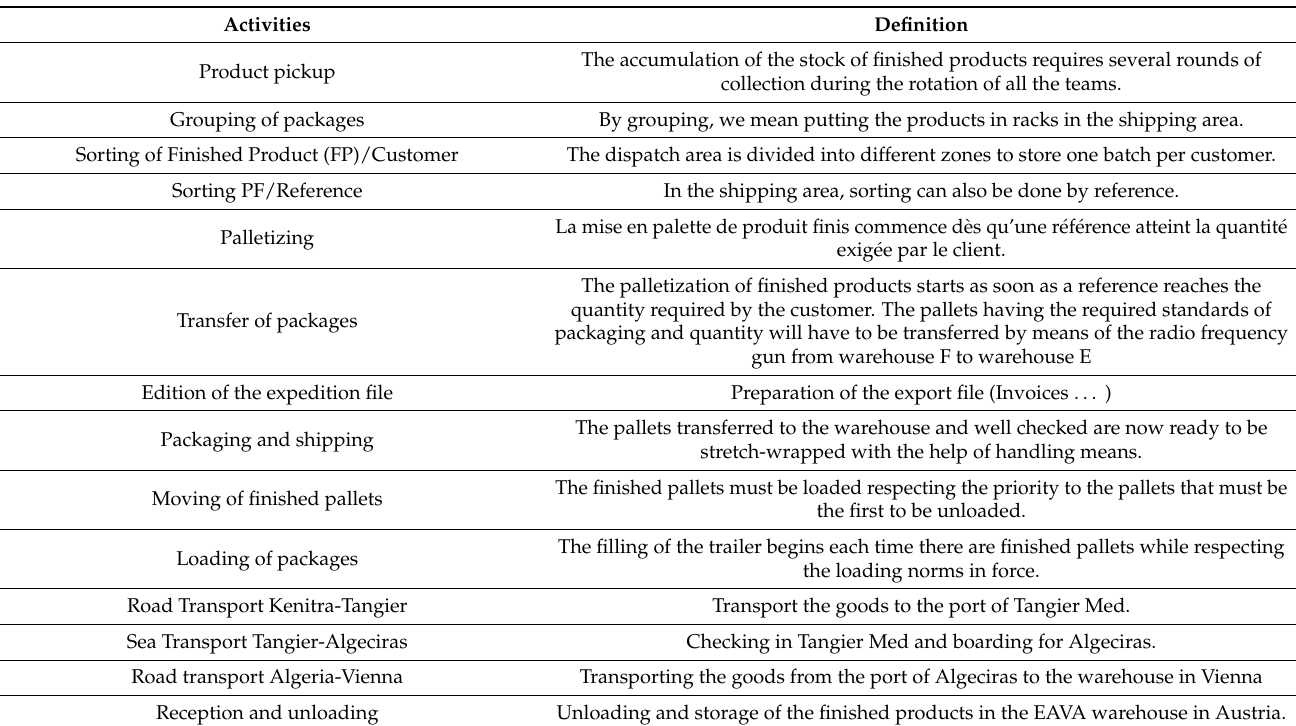
Table 3. The tasks of the distribution